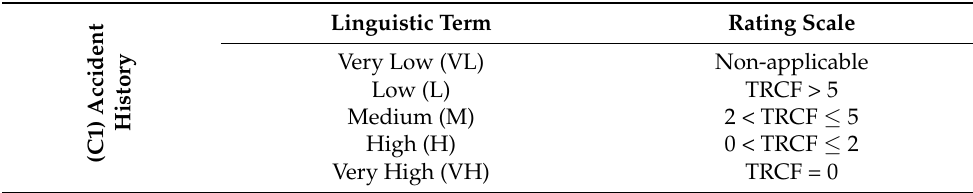
Table 3. Accident history (C1) rating scale.